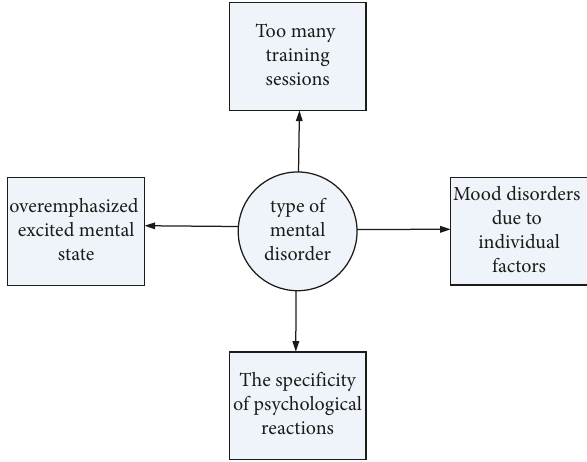
Figure 4: Barriers to mental training.